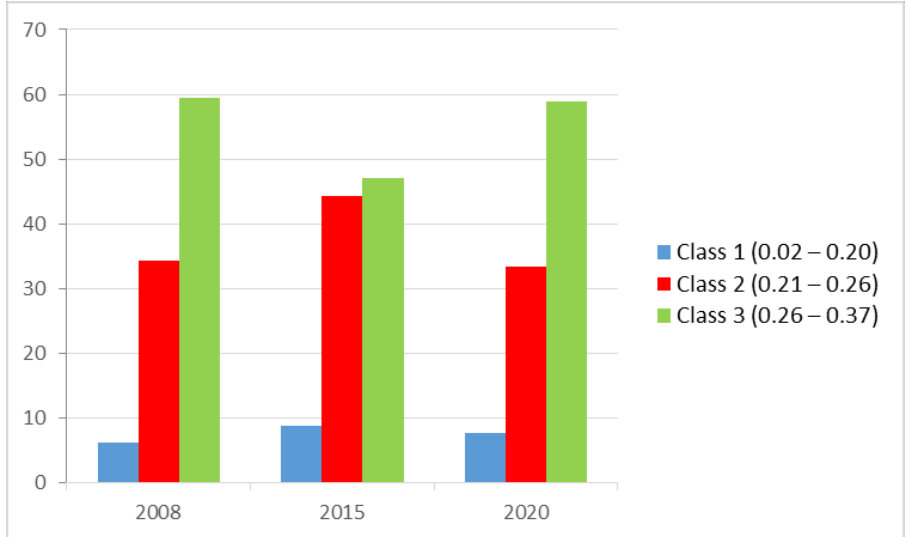
Figure 4. NDVI density classes changes during the period of 2008 to 2020.